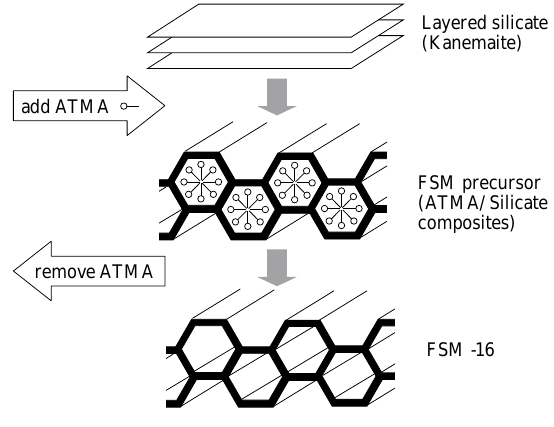
Comparison of synthesis methods for mesoporous molecu- lar sieve (modified from Beck [37] and Inagaki [38]).